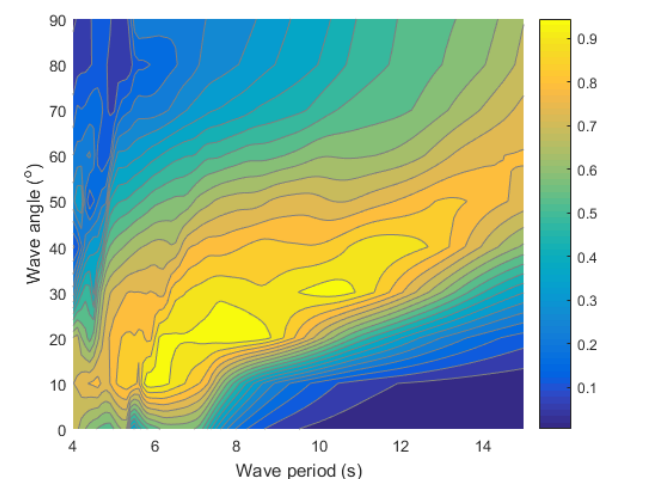
Fig. 6. Total capture width ratio of the duck spine system under constrained optimal power